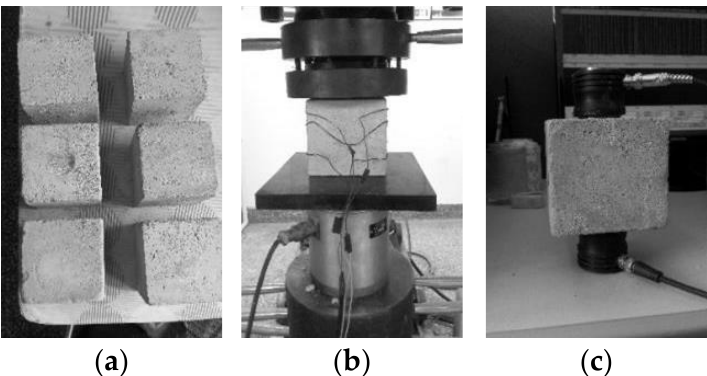
Figure 5. Division diagram of explosion cavity: ( a ) standard specimens, ( b ) compression test, ( c ) acoustic testing.